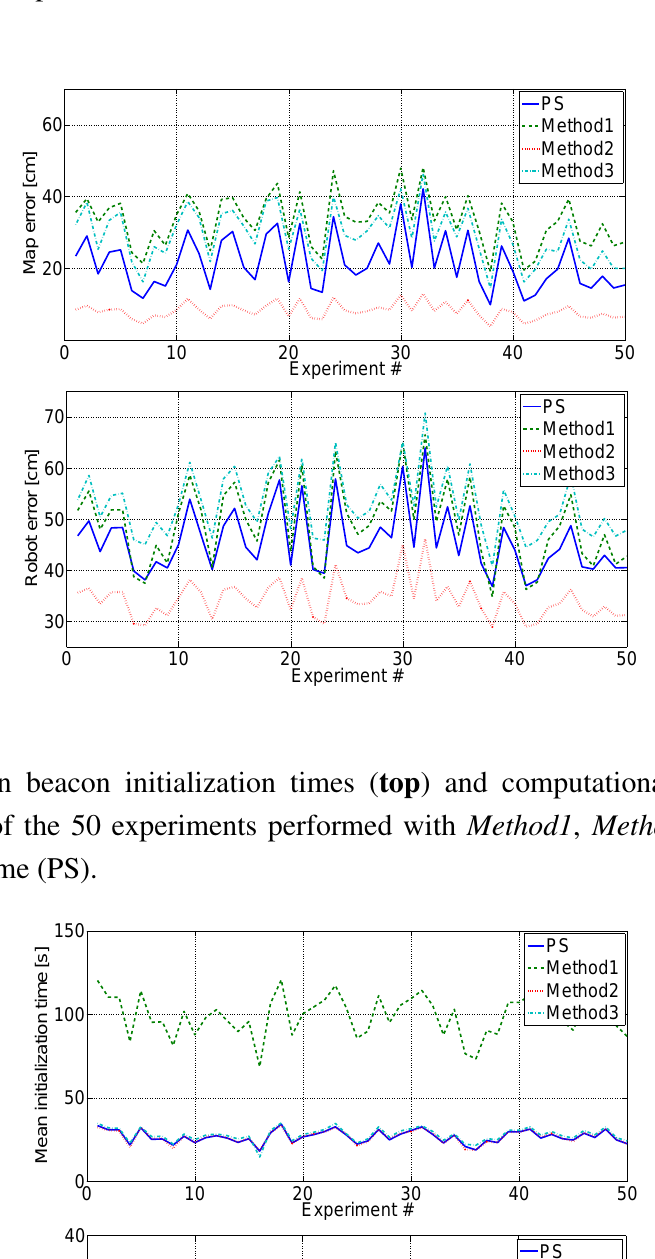
Figure 12. Mean beacon location errors ( top ) and mean robot location errors ( bottom ) in 50 experiments performed with Method1 , Method2 , Method3 and the proposed scheme (PS).